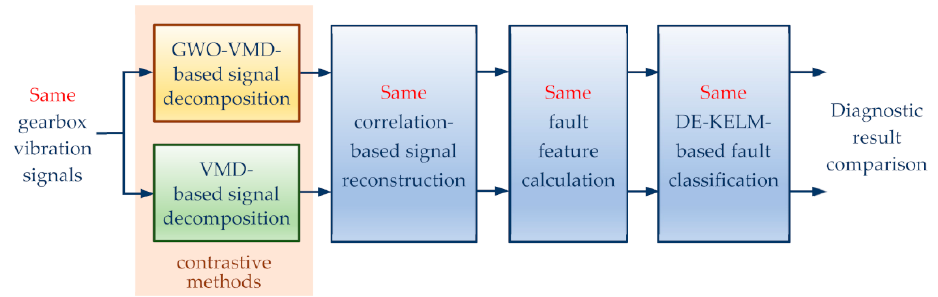
Figure 19. Process of contrast experiment I.